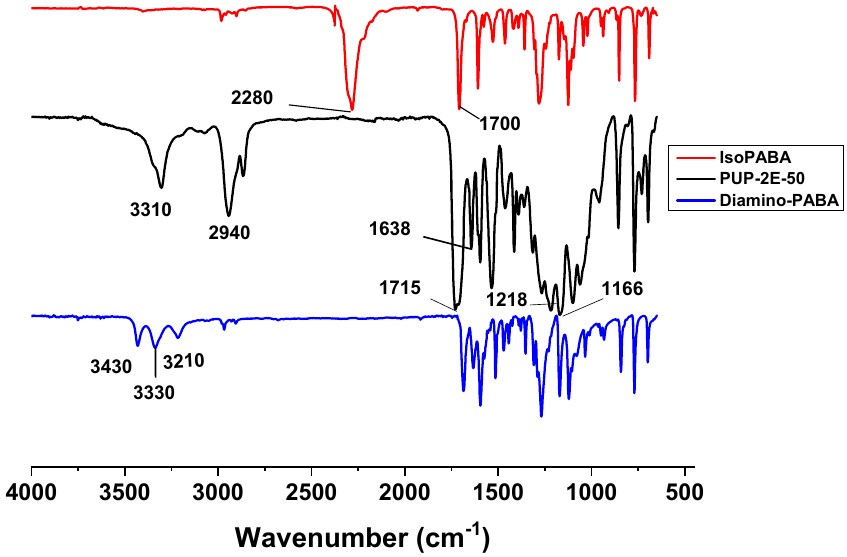
Figure 4. FTIR spectra of isoPABA, PUP-2E-50 and diamino-PABA. In the case of isoPABA (red spectrum), the intense bands at 2280 and 1700 cm − 1 were attributed to isocyanate (NCO) and ester (C=O) stretching vibrations, respectively. It